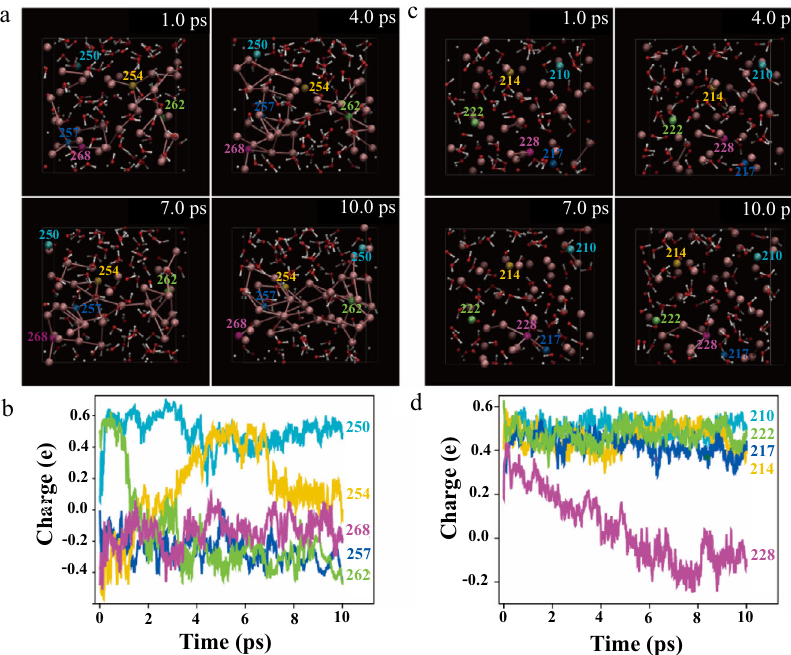
Fig. 4 Density functional theory-molecular dynamics simulations on the stabilization of the interphase. a Snapshots of the trajectory (1, 4, 7, 10 ps) of the dynamic structure under the electrically neutral condition. The electrically neutral model contained 40 In atoms (labeled from 240 to 279) and 80 H 2 O molecules in a cubic box with a length of 15.31 Å. b Charge of selected In atoms as a function of time under the electrically neutral condition. These atoms are labeled in a. c Snapshots of the trajectory of the dynamic structure (1, 4, 7, 10 ps) under positively charged condition. The In atoms are labeled from 200 to 239. d Charge of the selected In atoms as a function of time under positively charged condition. These particles are labeled in c . Atom color code: red, O; white, H; Other colors,